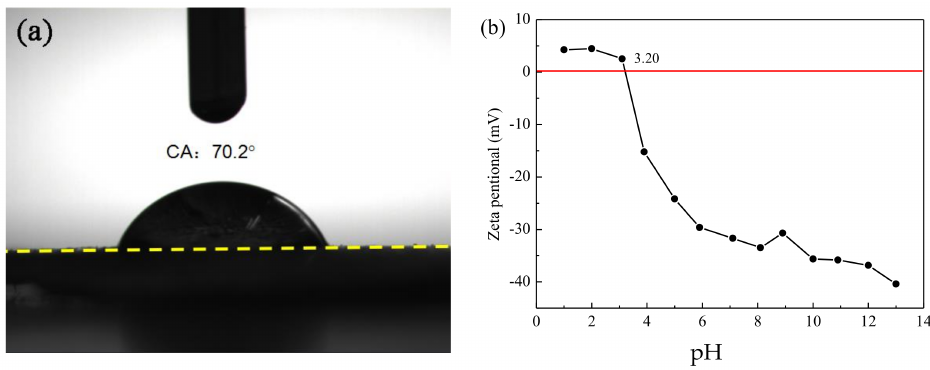
Figure 7. ( a ) CA and ( b ) Zeta potential vs. pH value of the flake BN.